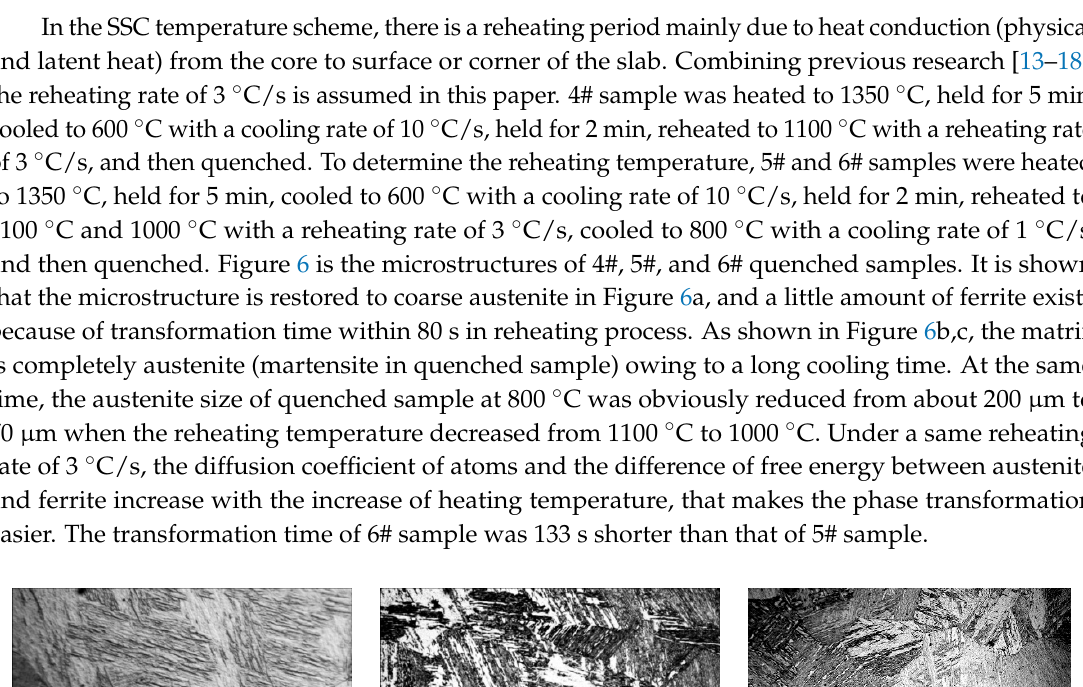
Figure 5. Quenching metallographic microstructure of different preservation times at 600 °C of microalloyed steel.